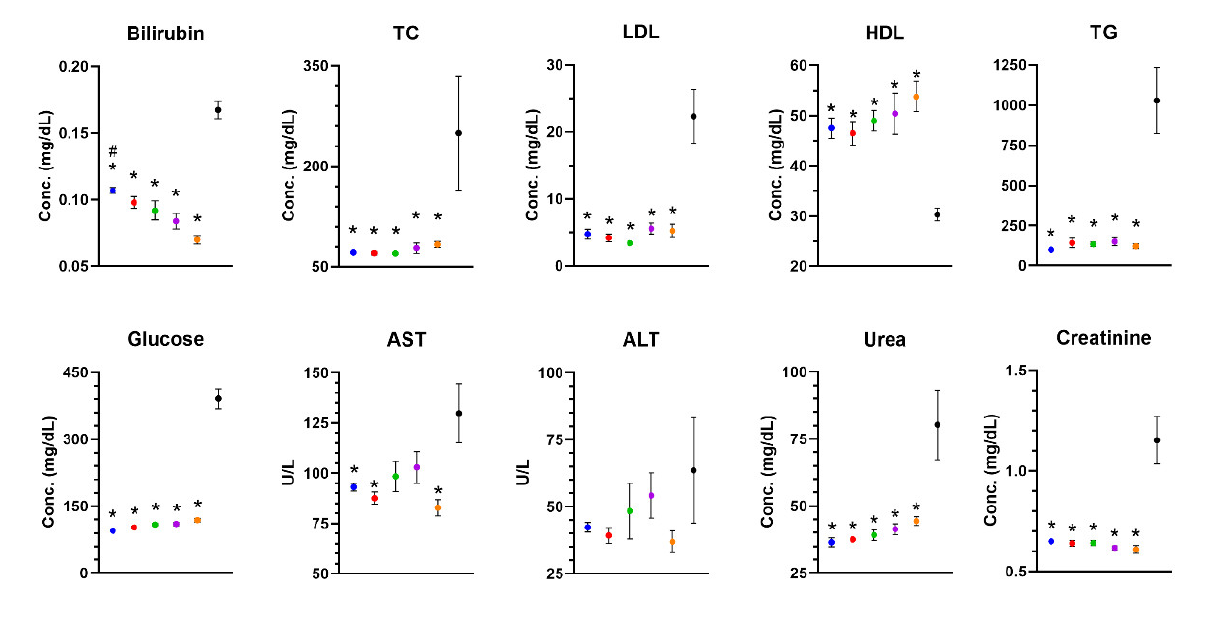
Figure 2. Results of the biochemical parameters (mean ± SEM). * represents statistical difference compared to the negative group treated with distilled water; # represents statistical difference com- pared to the positive group treated with simvastatin ( p < 0.05; ANOVA followed by Tukey